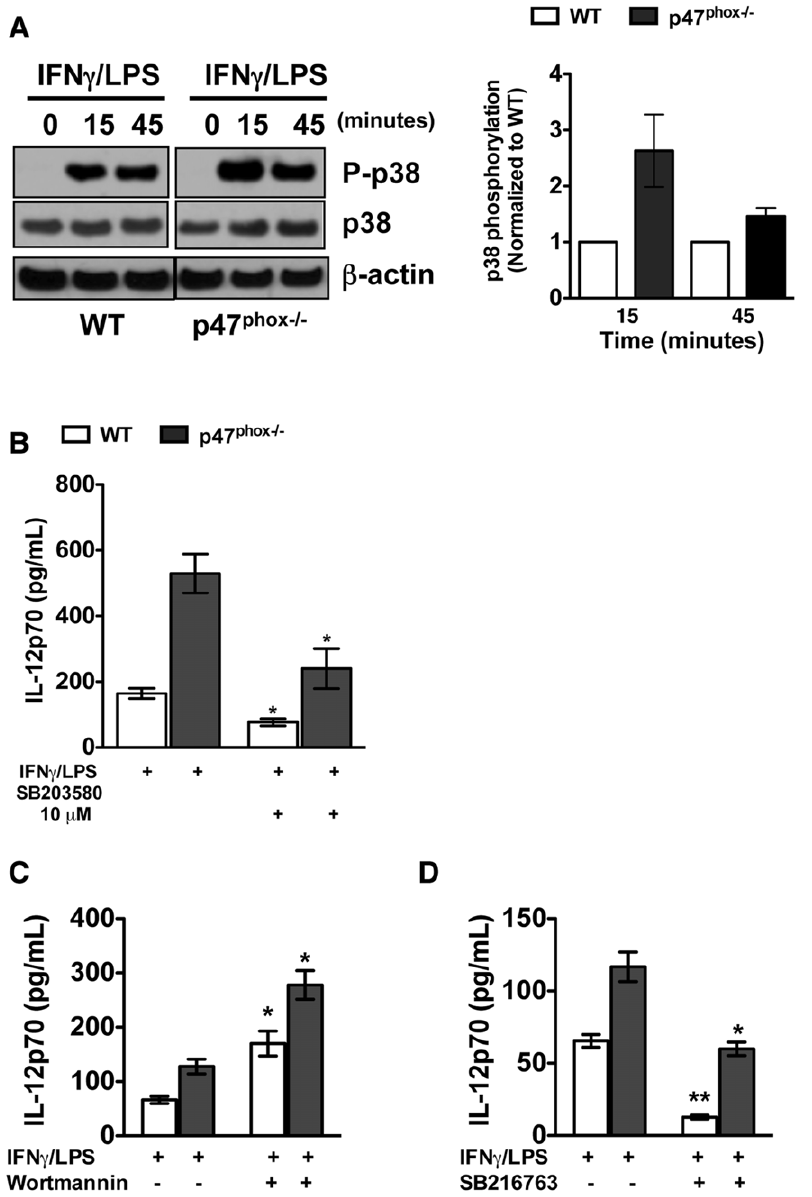
Figure 3. p47 phox attenuates IL-12p70 expression through PI3K-dependent negative regulation of p38-MAPK. (A) Detection of phosphorylated and total p38-MAPK was determined by Western blot of immature DC, 1 6 10 6 /ml, stimulated with IFN c /LPS for 0, 15, and 45 minutes as indicated (Density plot for n=4 experiments with 3 of each genotype/experiment). (B) Secreted IL-12p70 in supernatants from IFN c /LPS stimulated DC treated, or not, with SB203580. The data are the mean ( 6 SEM) percentage for 5 individual experiments with 3–4 of each genotype/experiment, with 5 6 10 5 DC/0.5 ml. Supernatants from IFN c /LPS-stimulated DC treated, or not, with Wortmannin (C) or SB216763 (D) were harvested from overnight cultures and assayed for secreted IL-12p70. The data are the mean ( 6 SEM) percentage for 3 individual experiments with 3–4 of each genotype/experiment with 2 6 10 5 DC/0.2 ml. * p , 0.003, **p # 0.0003.